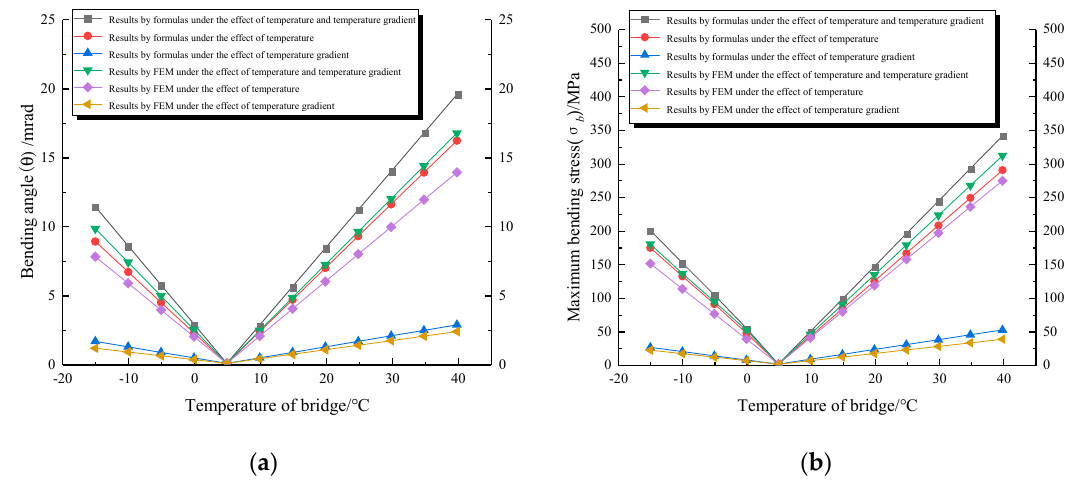
Figure 11. ( a ) Bending angles of the hanger; and, ( b ) maximum bending stress of the hanger.